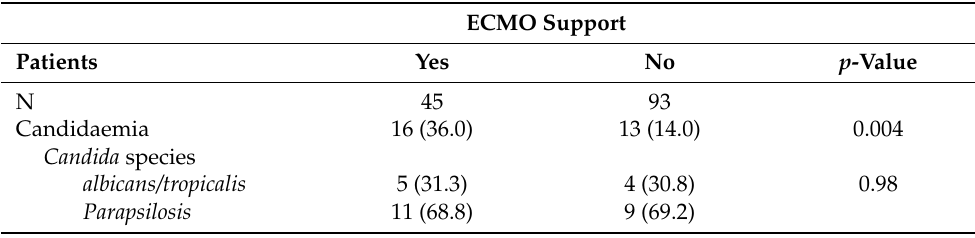
Table 2. Candidaemia cases and Candida species involved in patients admitted to the intensive care unit of Umberto I teaching hospital of Rome between March 2020 and June 2021 and who underwent IOT and mechanical ventilation. Results are expressed as number